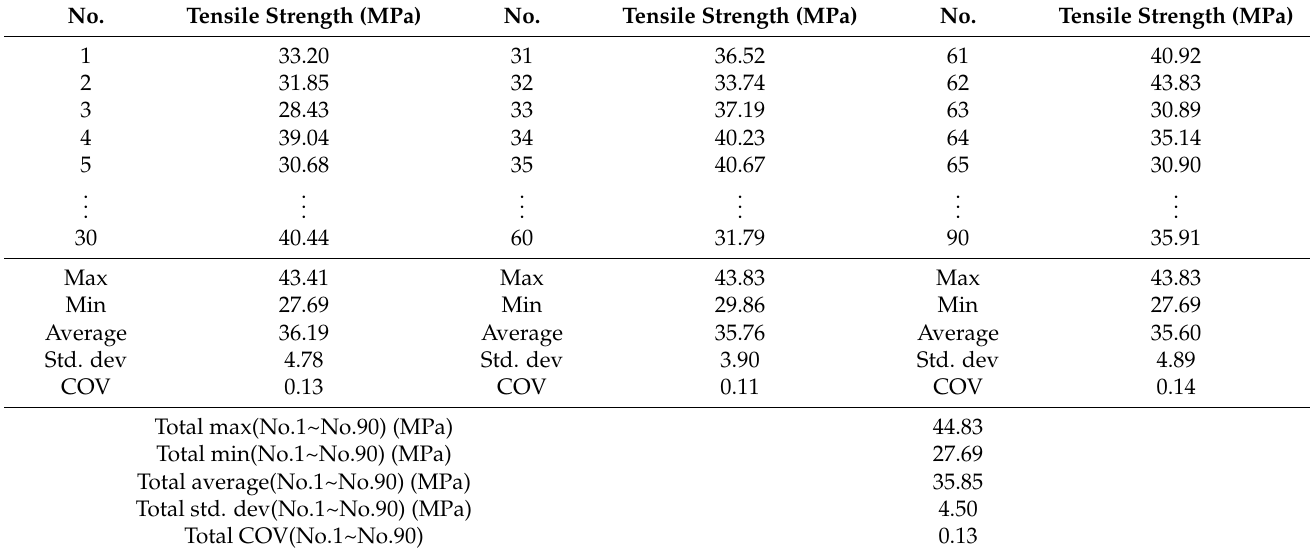
Table 3. Results of tensile tests for Case 1.